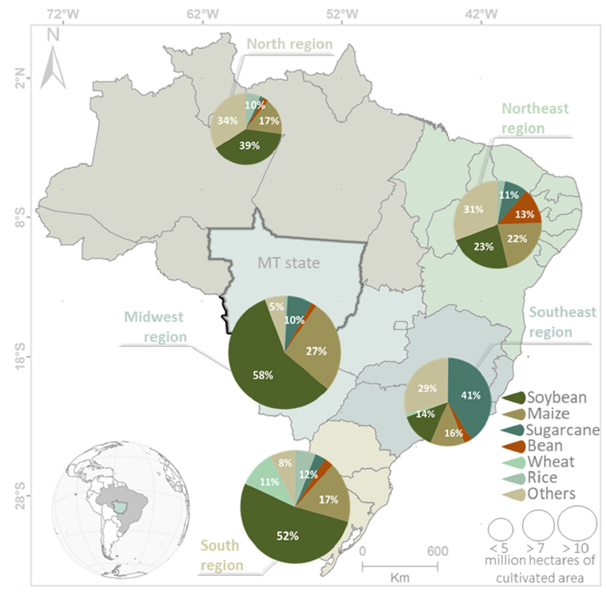
Figure 1. Location of Brazil in the American continent (inset figure) and location of Mato Grosso (MT) State in Brazil. Brazil and Mato Grosso State correspond to the two selected study areas of this paper. The country is divided into five regions: North, Northeast, Midwest, South, and Southeast. Pie graphs show the percentages of six major national crop types in Brazil by region. Source: IBGE [31].